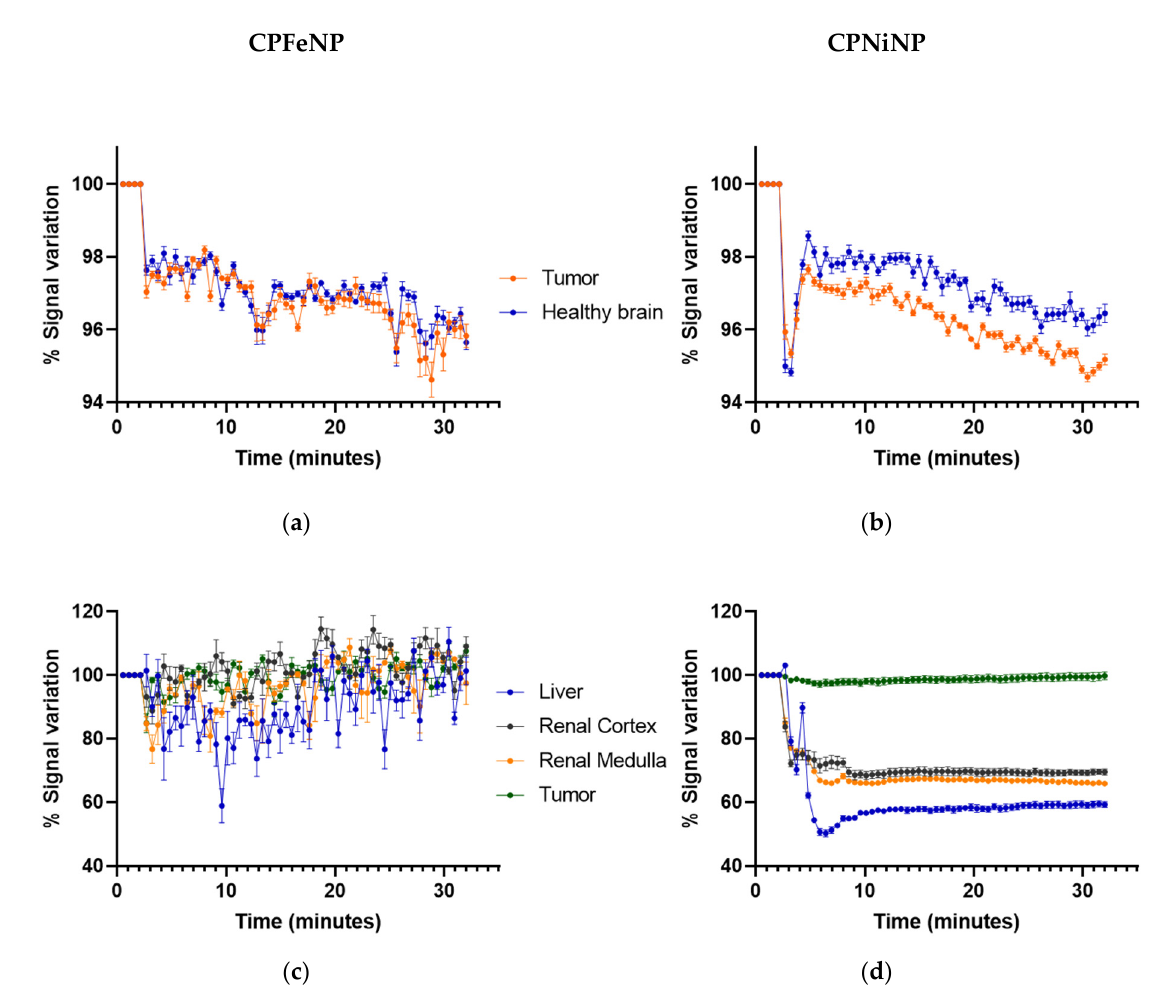
Figure 4 . Biodistribution MRI studies of ION-doped CPNs. Graphics show the variation in MRI signal intensity (mean ± SEM) in the different organs evaluated: tumor and contralateral healthy brain in the orthotopic glioma model for CPFeNP ( a ) and CPNiNP ( b ); and liver, renal cortex, renal medulla and tumor in the heterotopic GBM model for CPFeNP ( c ) and CPNiNP ( d ).